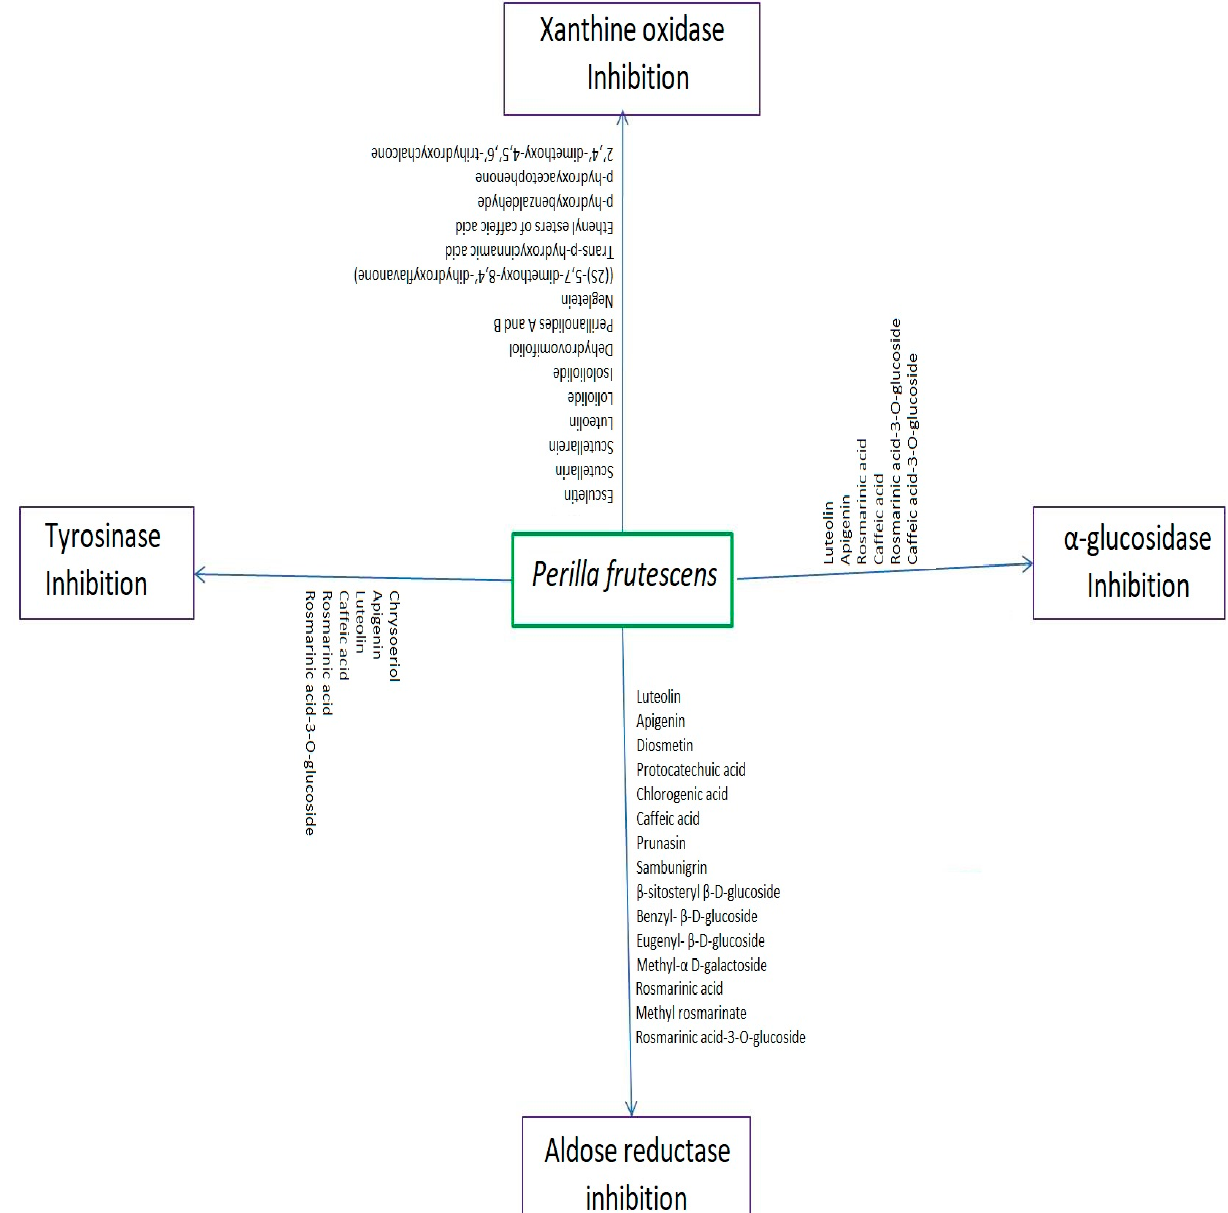
Figure 1 . Different bioactive compounds of P. frutescens involved in enzyme inhibitory activities . Figure 1. Different bioactive compounds of P. frutescens involved in enzyme inhibitory